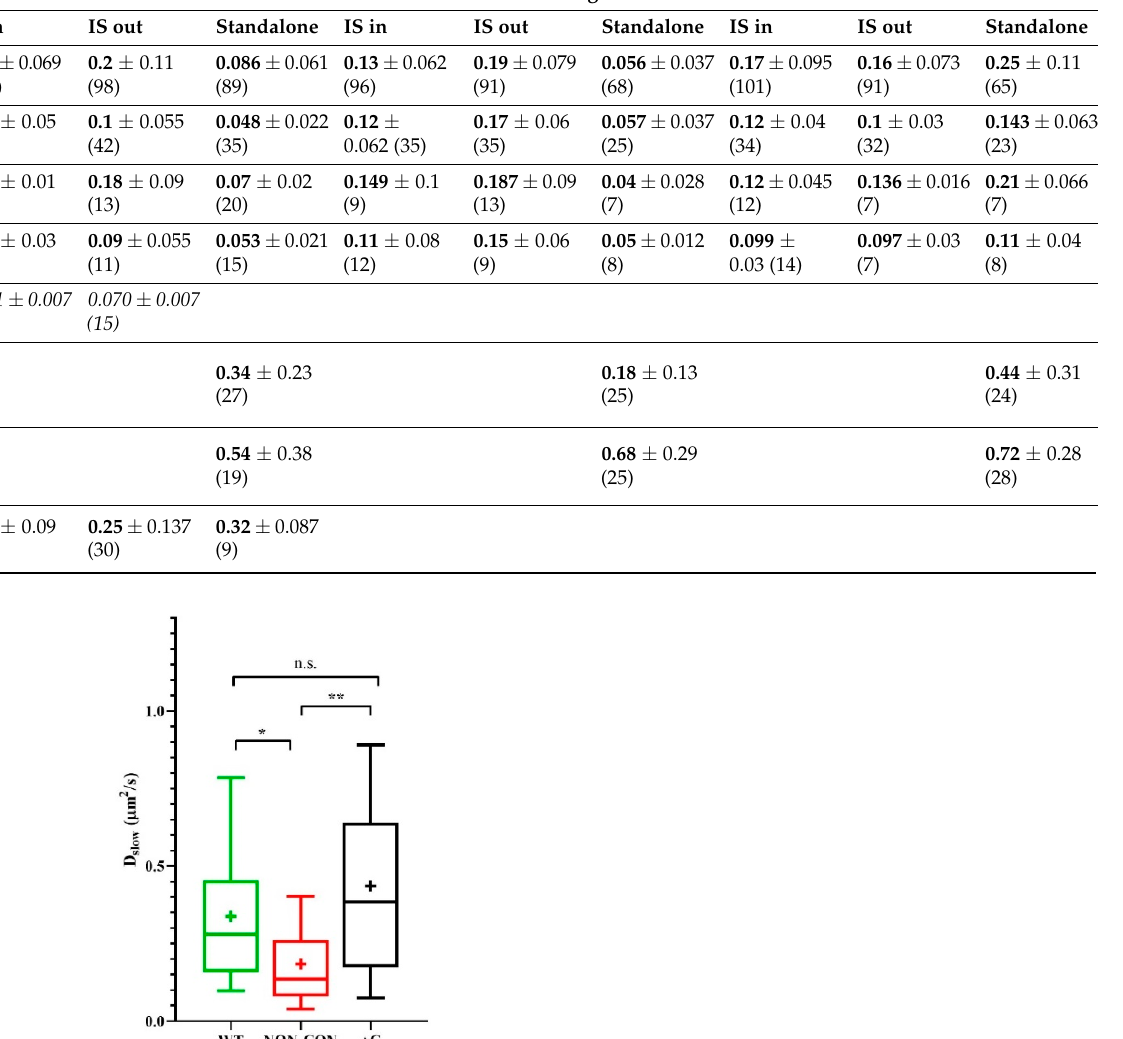
Figure 2. Mobility of MHC I heavy chain. Mobility of the MHC I glycoprotein was measured in standard solution in standalone Jurkat cells expressing WT, non-conductive point mutant (NON- CON), or C-terminal deleted mutant ( ∆ C) Kv1.3 channels. MHC I was labeled with Alexa546-W6/32 Fab. * p < 0.05, ** p < 0.01, n.s. not significant.